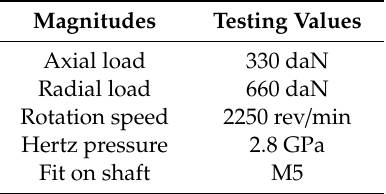
Table 7. Rolling contact fatigue (RCF) testing conditions for industrial components.